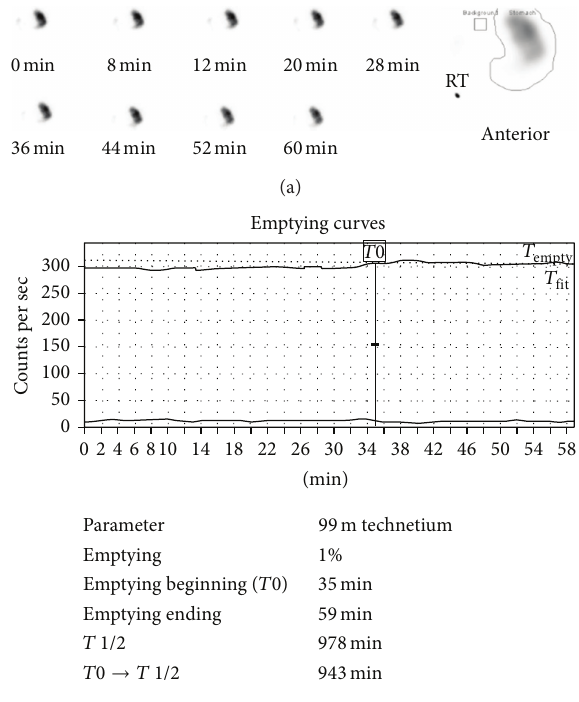
Figure 2: Gastric emptying study for patient KS following open right hepatectomy. (a) Gastric emptying was observed for 60 min- utes with intermittent imaging. The region of interest is indicated at right by a line drawn around the activity within the stomach in the anterior view. (b) The emptying curves over 60 minutes ( 𝑇 —dotted) are shown. The half-emptying time ( 𝑇 1/2) was solid; 𝑇 fit calculated using the geometric mean. Gastric emptying time was markedly prolonged, with absent emptying during the 60-minute